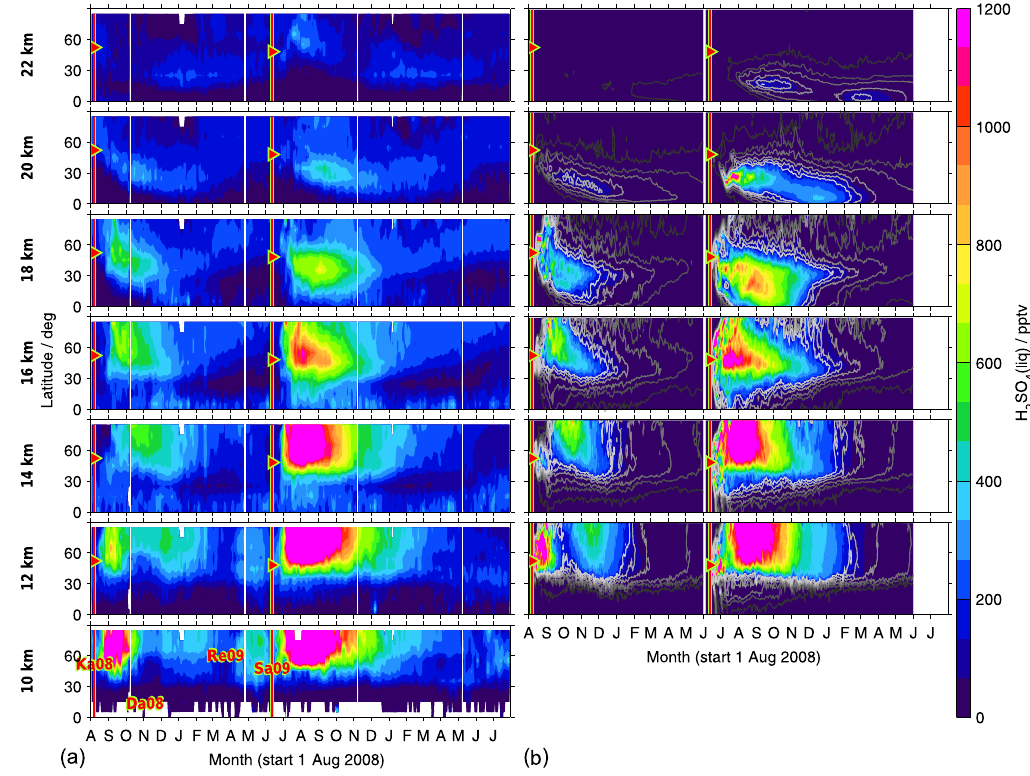
Figure 10. As Fig. 9 but for sulfate aerosol. (b) Black to white contour lines denote 5, 25, 50, 100, 150, and